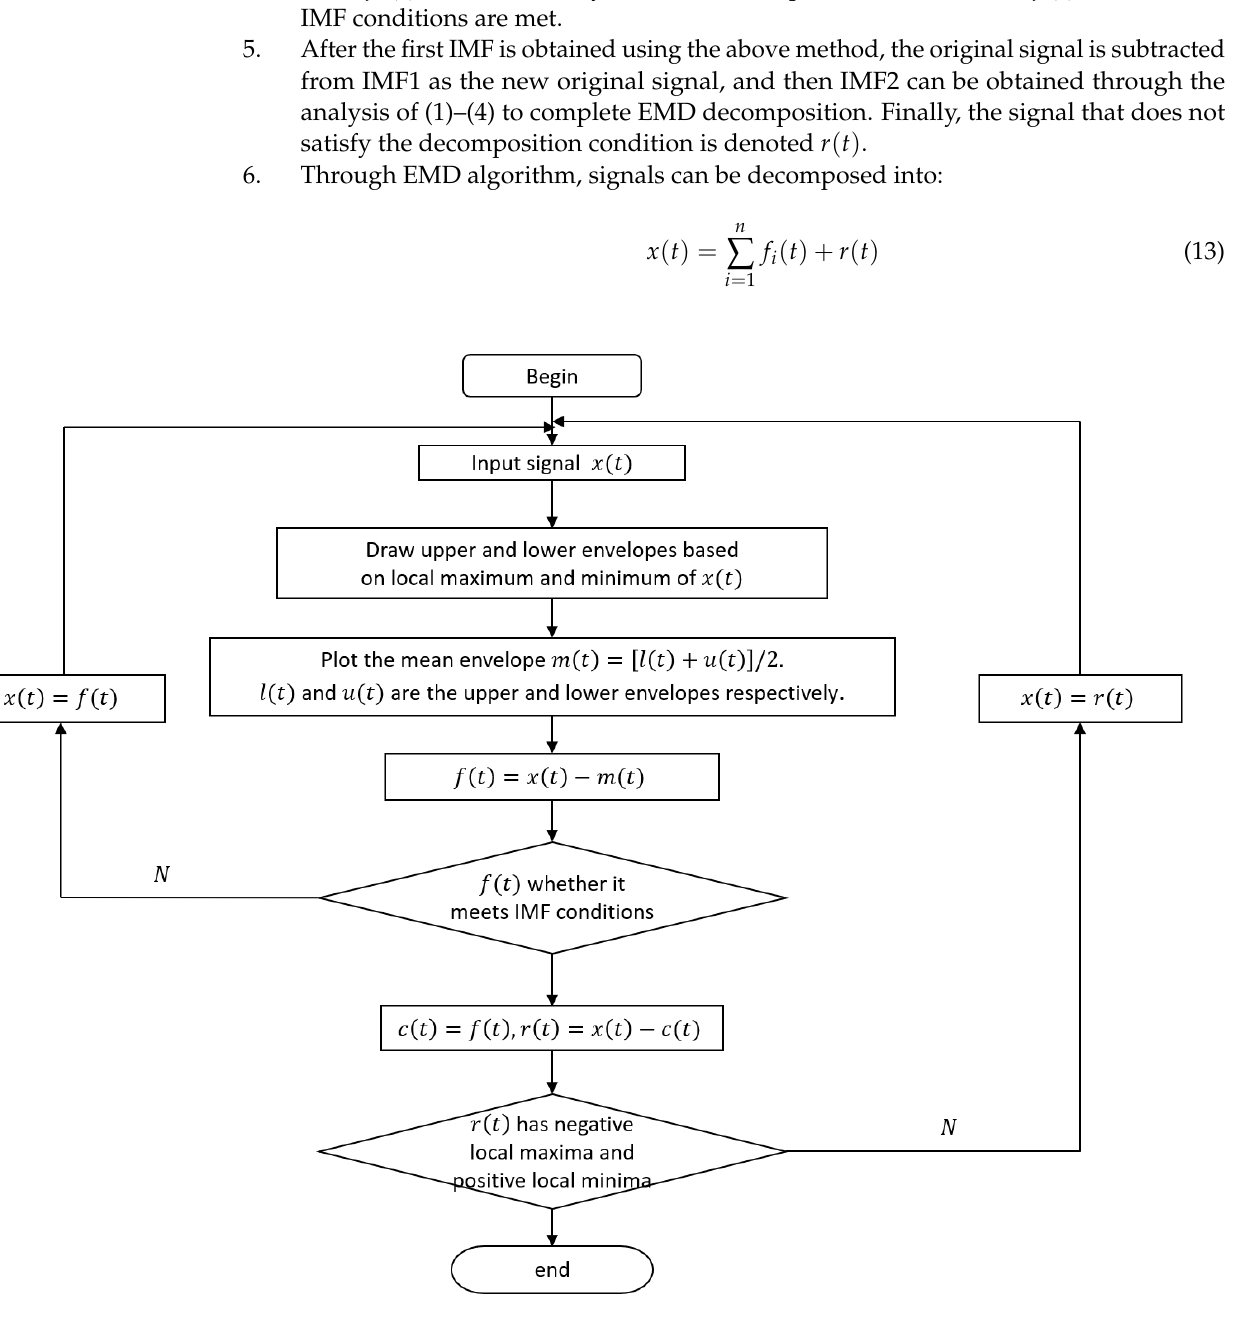
Figure 6. The EMD flowchart.